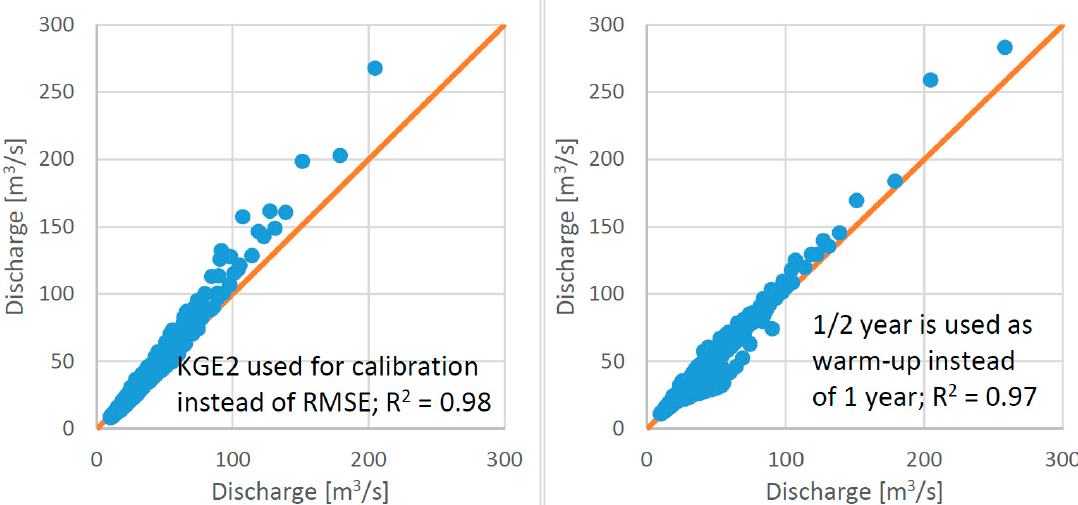
Figure 7. Impact of the efficiency criteria used for the CemaNeige GR6J model calibration ( left figure ) and impact on the length of the model warm-up period ( right figure ) on the model results in the validation period for the Blejski most station on the Sava Dolinka river. In both cases, the x-axis shows discharge values obtained using Equation (1), RMSE as a criterion for the calibration, and one year as a warm-up period. In the left figure, the y-axis shows the results using the KGE2 for model calibration. In the right figure, the y-axis shows the results using half-year data for the model warm-up period instead of one year.